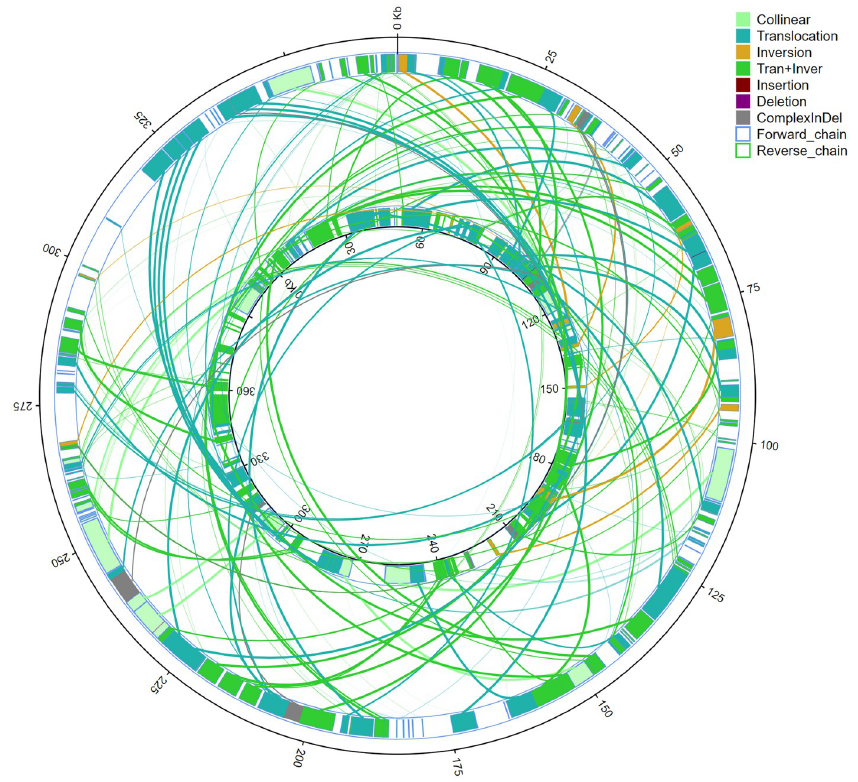
Fig 6. Structural variation map of mitochondrial genomes of Gentiana crassicaulis and G . straminea . The inner circle is the G . crassicaulis genome, and the outer circle is the G . straminea genome. Collinear: homologous region; translocation: translocation region; inversion: inverted region; tran+inver: translocation and inversion region; insertion: insertion region with length � 50 bp; deletion: deletion region with length � 50 bp; complexInDel: region without alignment but corresponding to location; forward_chain: forward chain of a genomic sequence, at which time the gene sitz markers increase clockwise; reverse_chain: the reverse chain of a genomic sequence, where the gene coordinates increase